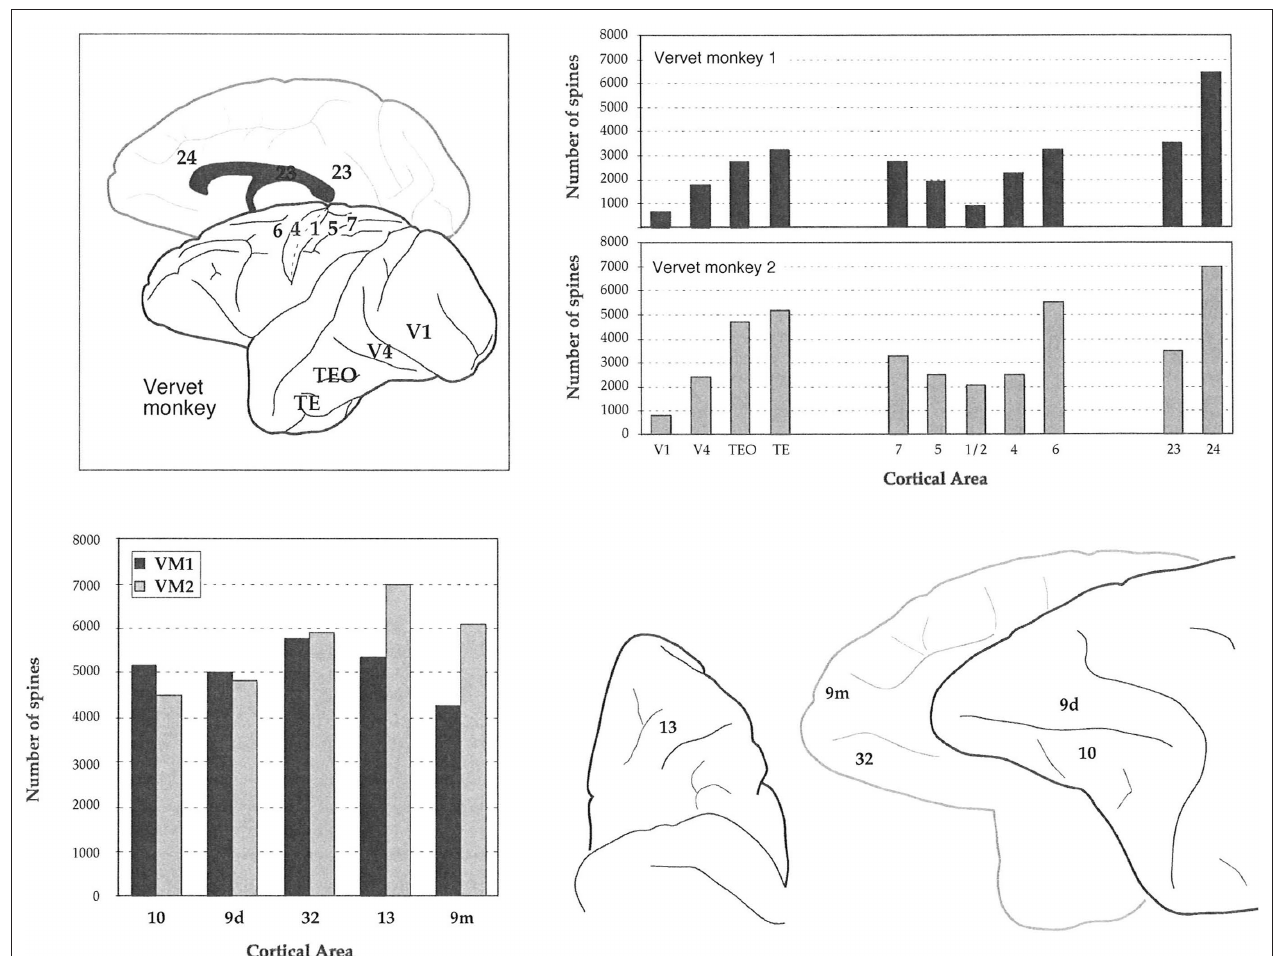
estimates of the total number of dendritic spines in the basal dendritic tree of the “average” layer III pyramidal cell among cortical areas (bottom left), despite standardizing the regions sampled between cases (bottom right). V1 = primary visual, V2 = second visual, V4 = fourth visual, 3b = primary somatosensory, 1/2/5/7 = somatosensory association, 4 = primary motor, 6 = premotor, 23 = posterior cingulate, 24 = anterior cingulate, 9/10/12/13/46 = prefrontal areas, 32 =